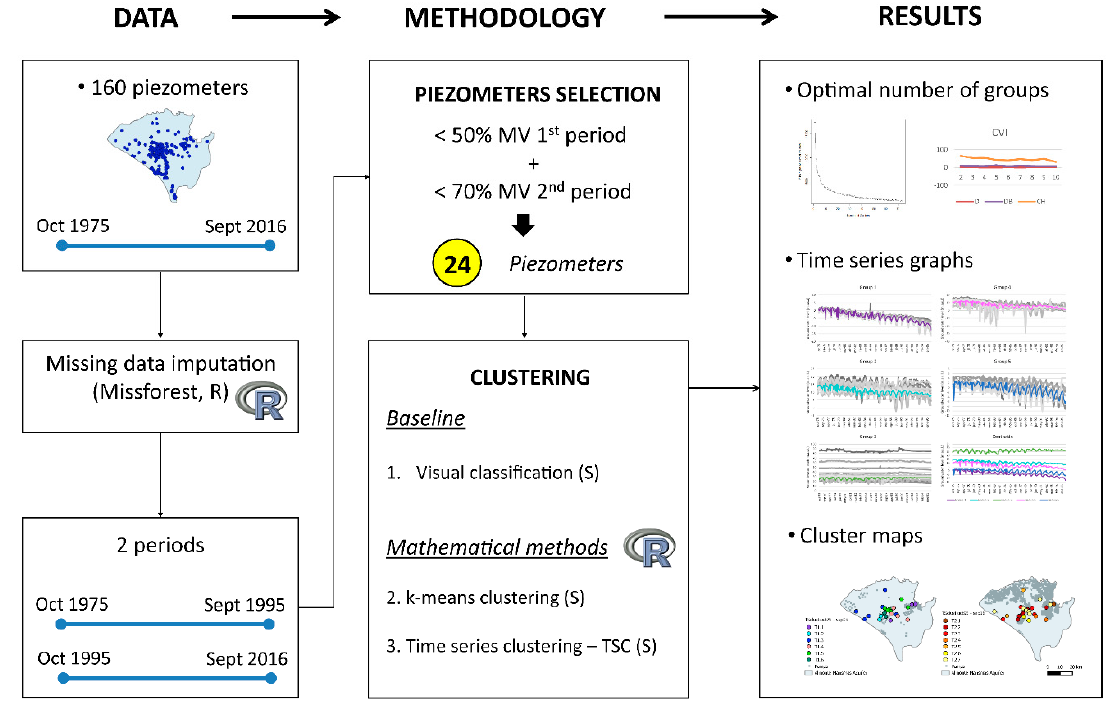
Figure 2. Flowchart of the methodological approach used in the current study. S: standardization as pre-treatment.